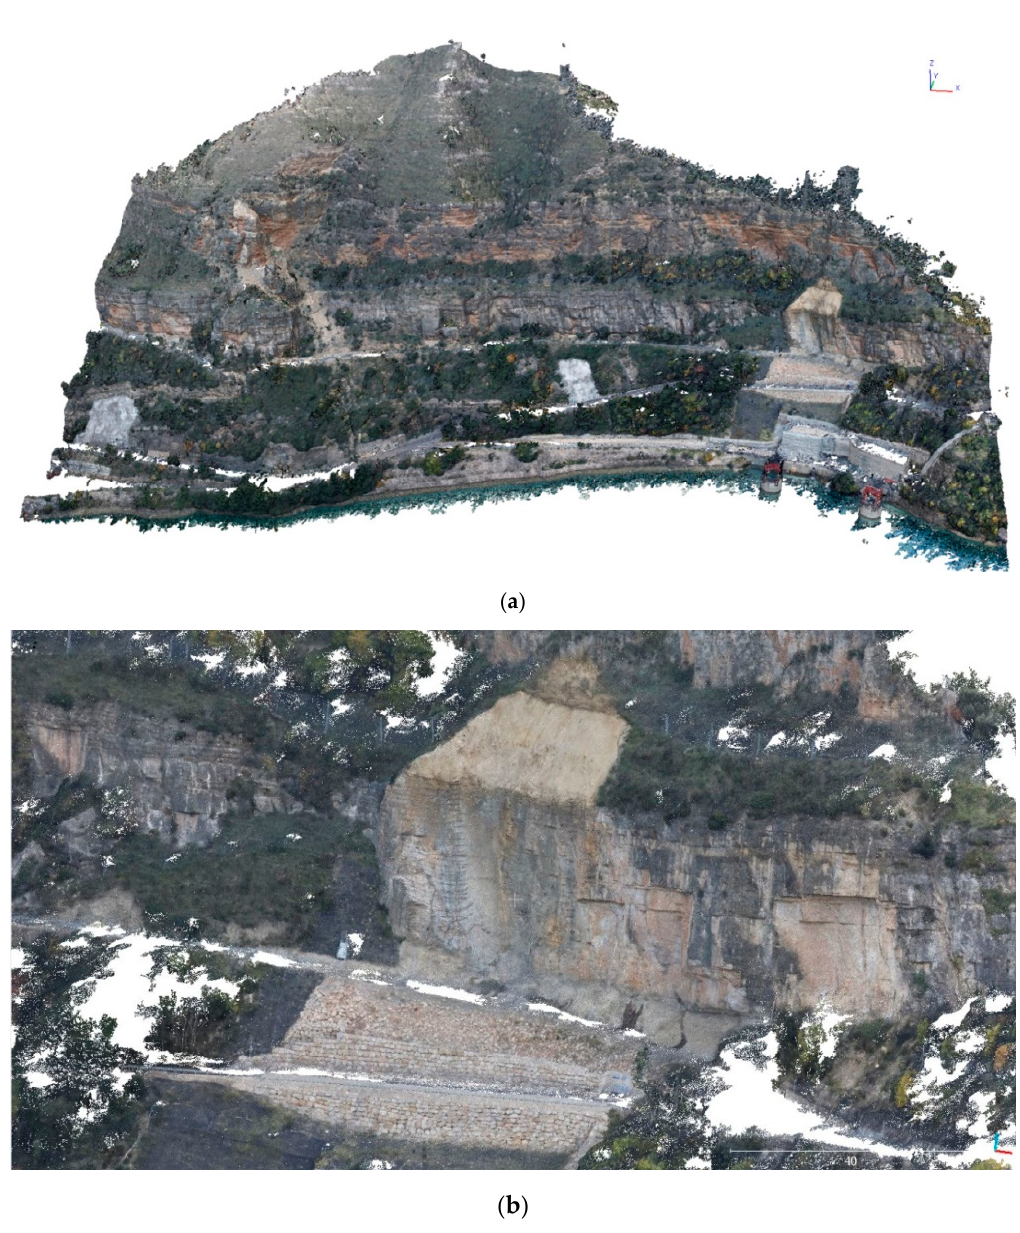
Figure 7. Cortes de Pallás sector: ( a ) point cloud without filtering; ( b ) cleaned and filtered point cloud.